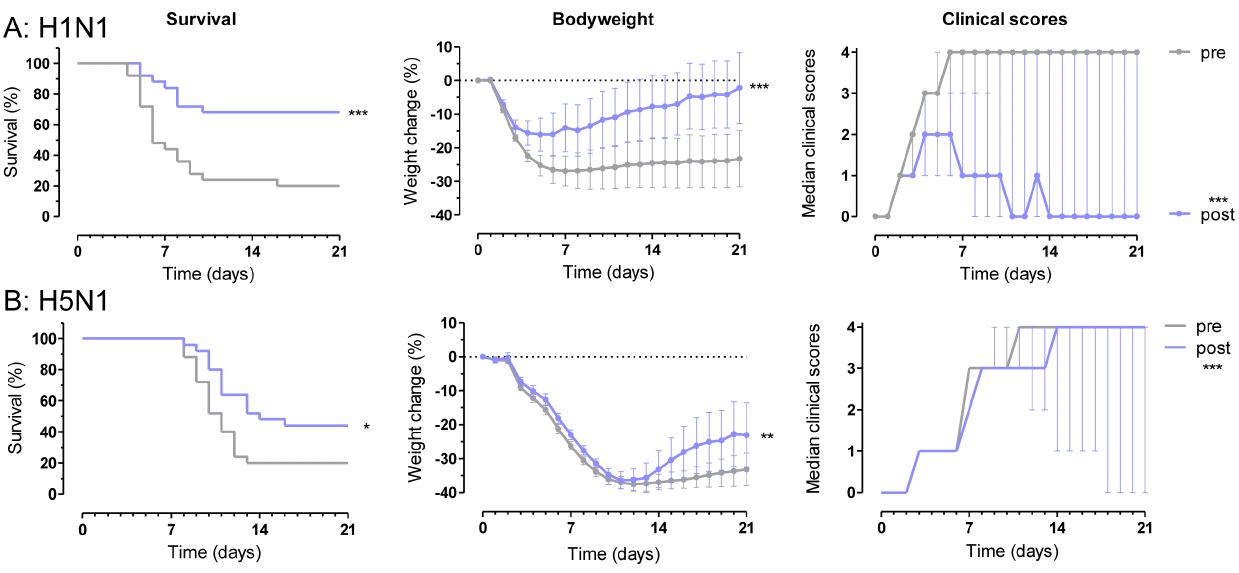
Figure 2. Serum from humans immunized with seasonal influenza vaccine protects mice against vaccine homologous H1 and heterosubtypic H5 influenza challenge. Kaplan-Meier survival curves (left), mean bodyweight change (middle) and median clinical score (right) graphs are shown for mice that received either pre- or post-vaccination serum (grey and blue lines, respectively) following lethal challenge with ( A ) H1N1 or ( B ) H5N1 virus. Error bars indicate 95% confidence interval (bodyweight) or interquartile range (clinical scores). Average bodyweight loss and median clinical score data are presented with last observation carried forward for mice that succumb to infection. Post-vaccination serum confers significant protection against H1N1 and H5N1 influenza challenge relative to pre-vaccination serum. p , 0.05=*, p , 0.01=**, p , 0.001=***.